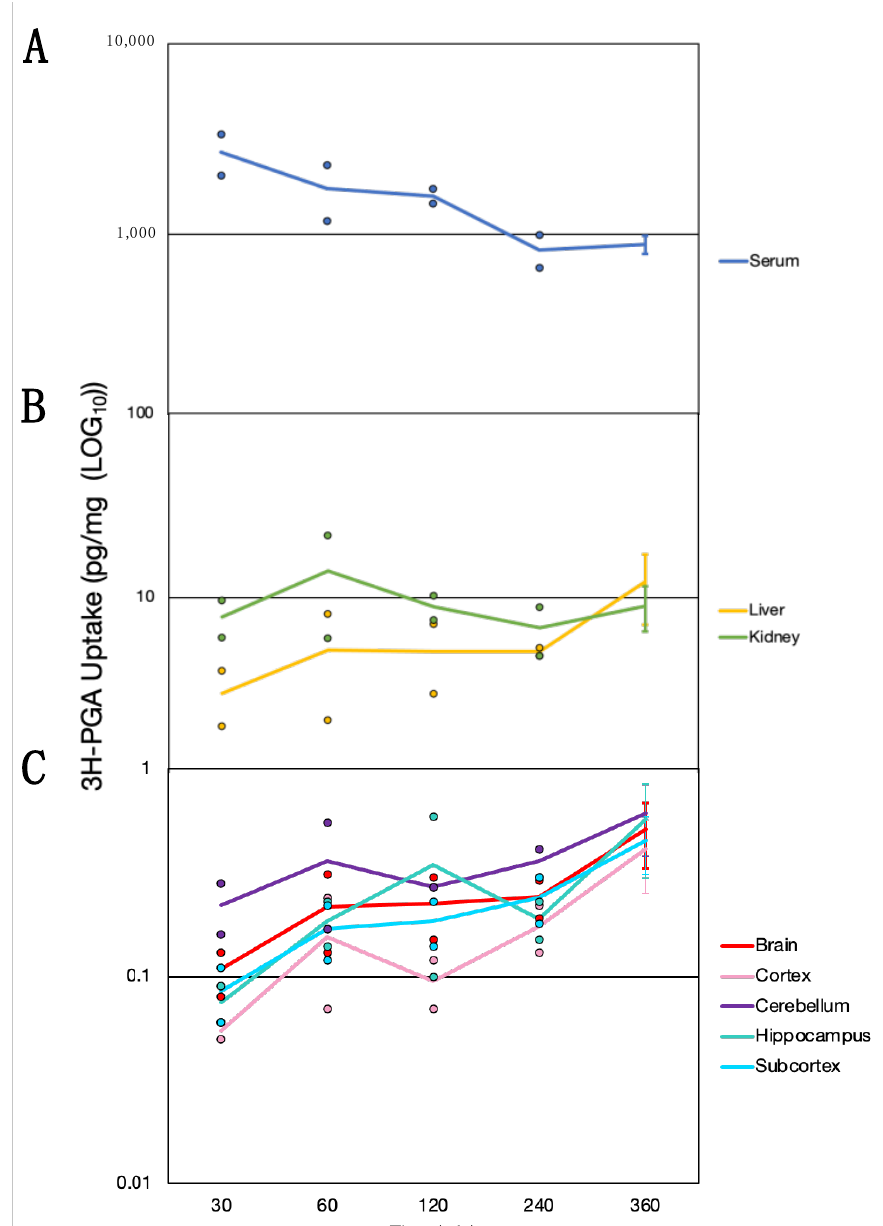
Figure 4. The time course of orally administered 3 H-PGA appearing in ( A ) blood serum (blue), ( B ) liver (yellow) and kidney (green), and ( C ) brain regions (total Brain (red), cortex (pink), cerebellum (purple), hippocampus (turquoise), subcortex (blue)) over time. Sample sizes; n = 2 for 30–240 min n = 6 for 360 min. Solid lines represent the mean while individual values are shown for timepoints 30–240 min. The standard deviation is shown for 360 min.